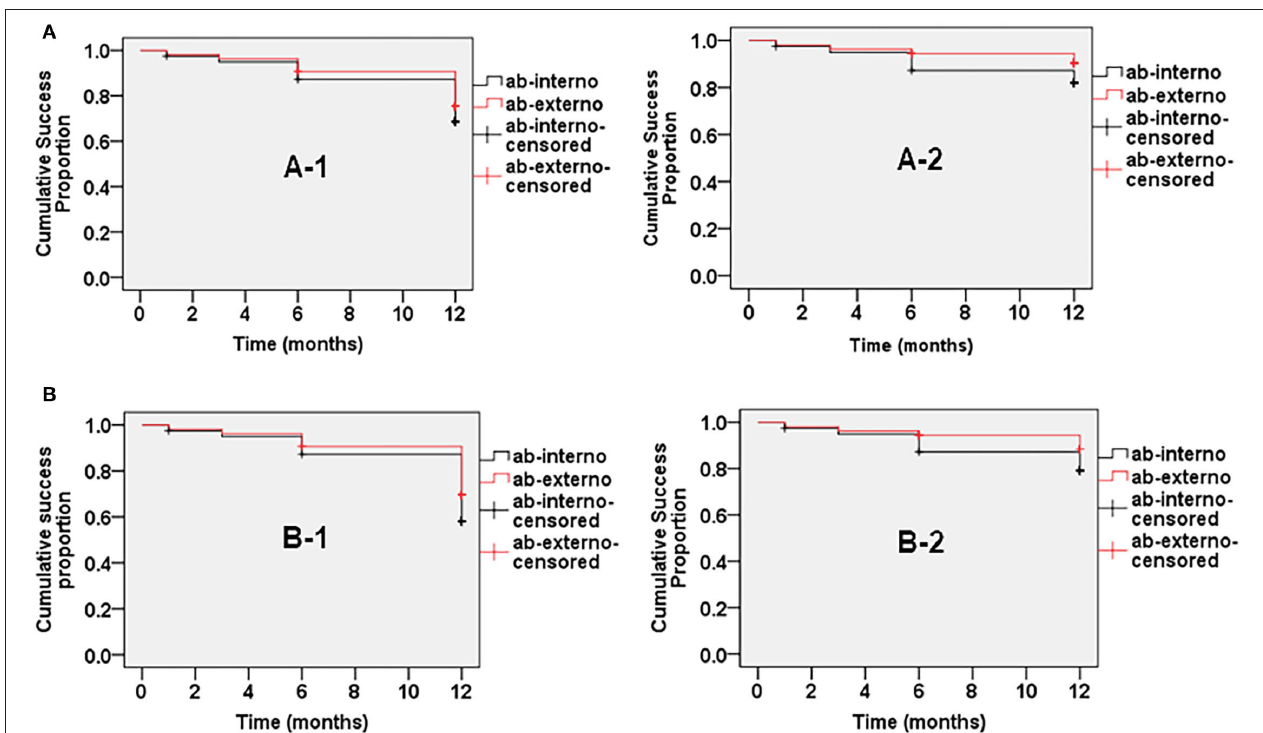
FIGURE 1 | The cumulative success probabilities of abinterno (red) and ab externo (black) circumferential trabeculotomy. (A) Complete (A-1) and qualified (A-2) success (success criterion: IOP ≤ 21 mmHg and a reduction of IOP ≥ 20% from baseline). (B) Complete (B-1) and qualified (B-2) success (success criterion: IOP ≤ 18 mmHg and a reduction of IOP ≥ 20% from